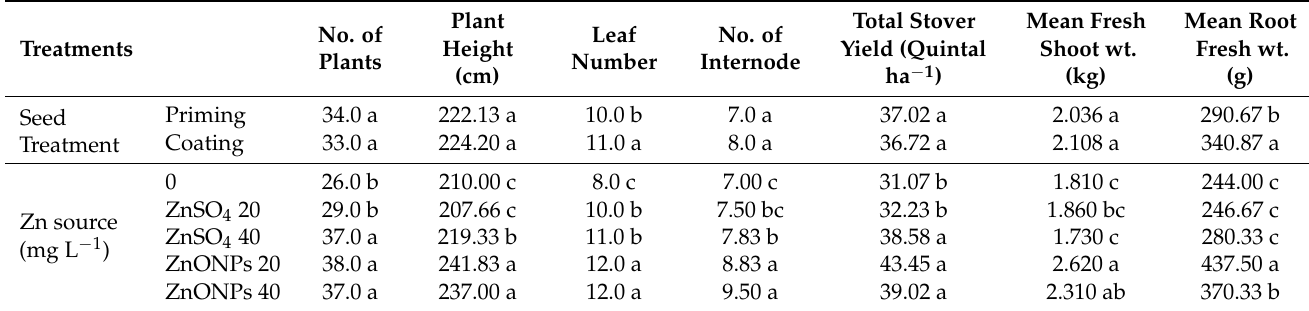
Table 2. Effect of seed treatments with different concentrations of ZnONPs on vegetative and yield attributing parameters of fodder maize crop (variety J-1006) grown under field